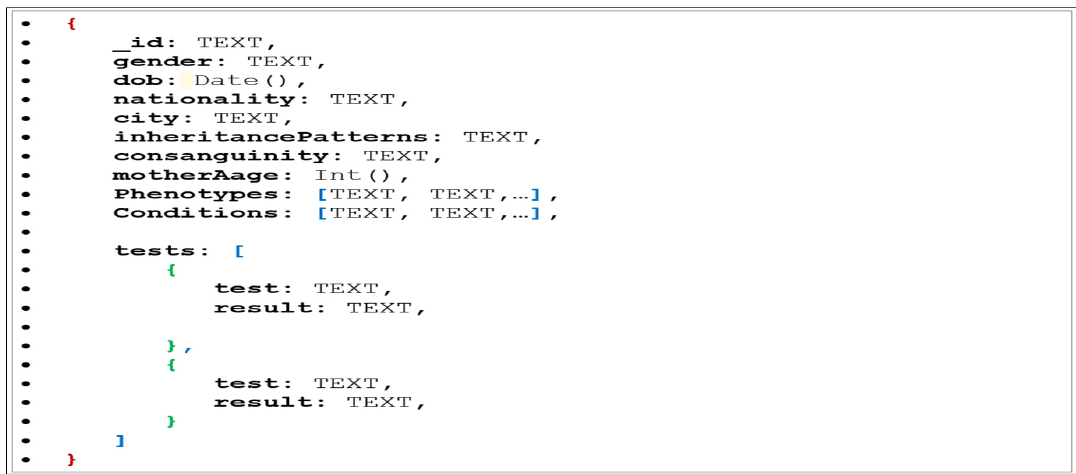
Figure 4. The schema design for the patient document.